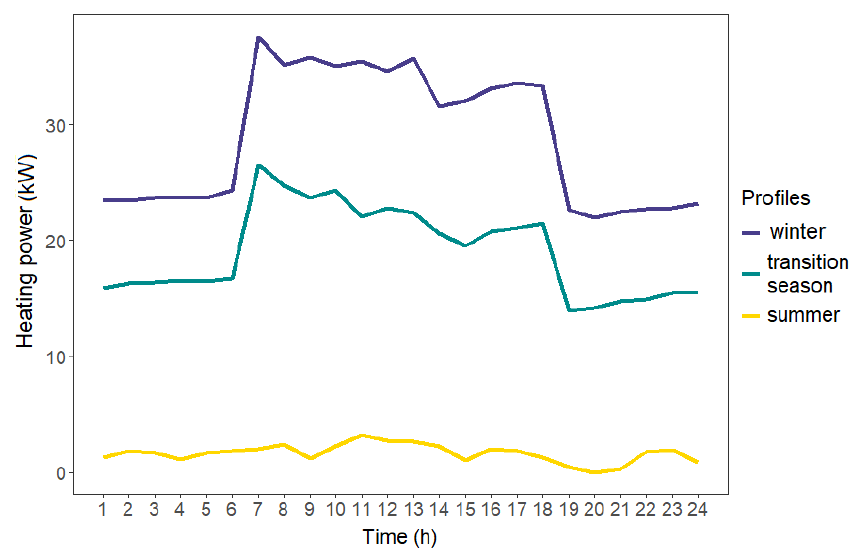
Figure 9. Representative seasonal heating load profiles of the case study building.